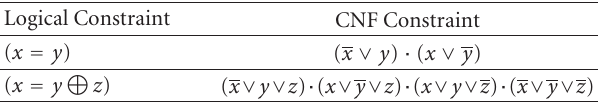
Table 1: Expressing logical constraints using CNF constraints. Logical Constraint